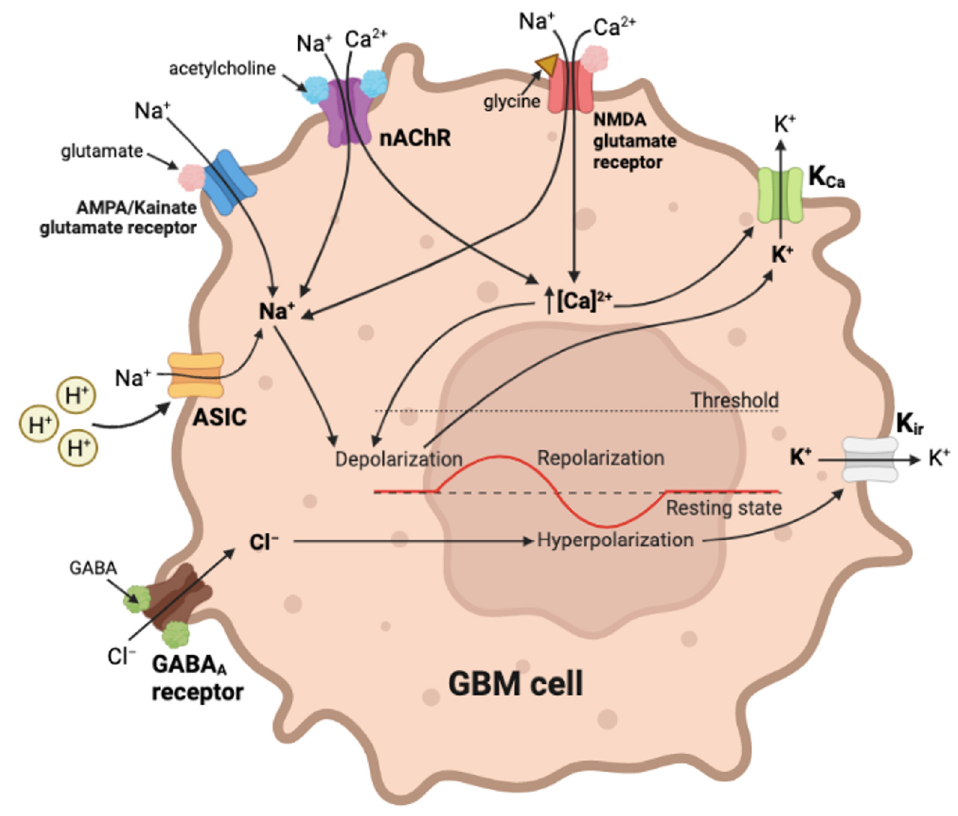
Figure 3. Multiple classes of channels and receptors are expressed in GBM cells; a subset are shown here for illustration. AMPA/kainate-and NMDA-type glutamate receptors carry net inward Na + currents, and a subset also facilitates Ca 2+ influx. Nicotinic ACh receptors (nAChR) induce depolarizing Na + (and subtype-dependent Ca 2+ ) influxes. ASICs open in response to acidic extracellular conditions, allowing Na + influx. Intracellular Ca 2+ activates K Ca channels, driving repolarization. Inhibitory GABA A receptors enable a hyperpolarising net influx of Cl − . K ir channels to maintain the negative resting membrane